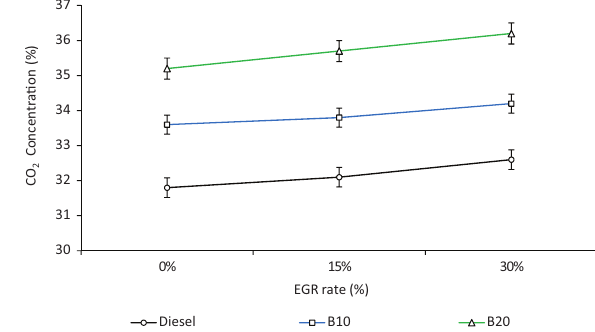
Figure 5. Effect of oxygenated fuel and different EGR rates on CO 2 concentration in the exhaust gas under 1800 rpm